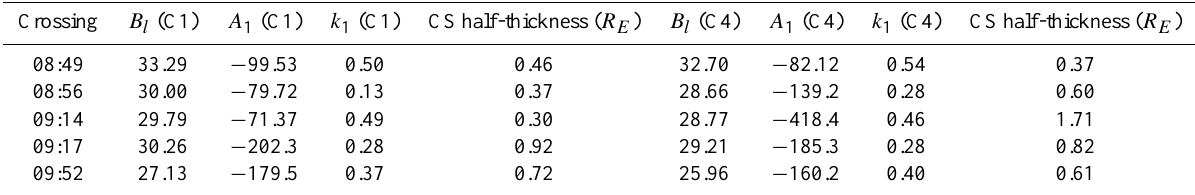
Fig. 12. Plots of (a) the average B X across the Cluster spacecraft, (b) the total current density against Z * and (c) DivB/CurlB against Z * for each of the current sheet crossings by Cluster. The times above the top row show the centre time ( t =0) of each column. Table 4. The lobe magnetic field strength, the gradients between V Z and dB X /dt ( A 1 ) and B Y and B X ( k 1 ), and the current sheet half- thicknesses determined using the method of Sergeev et al. (1998) for the current sheet crossings by Cluster 1 (C1) and Cluster 4 (C4).